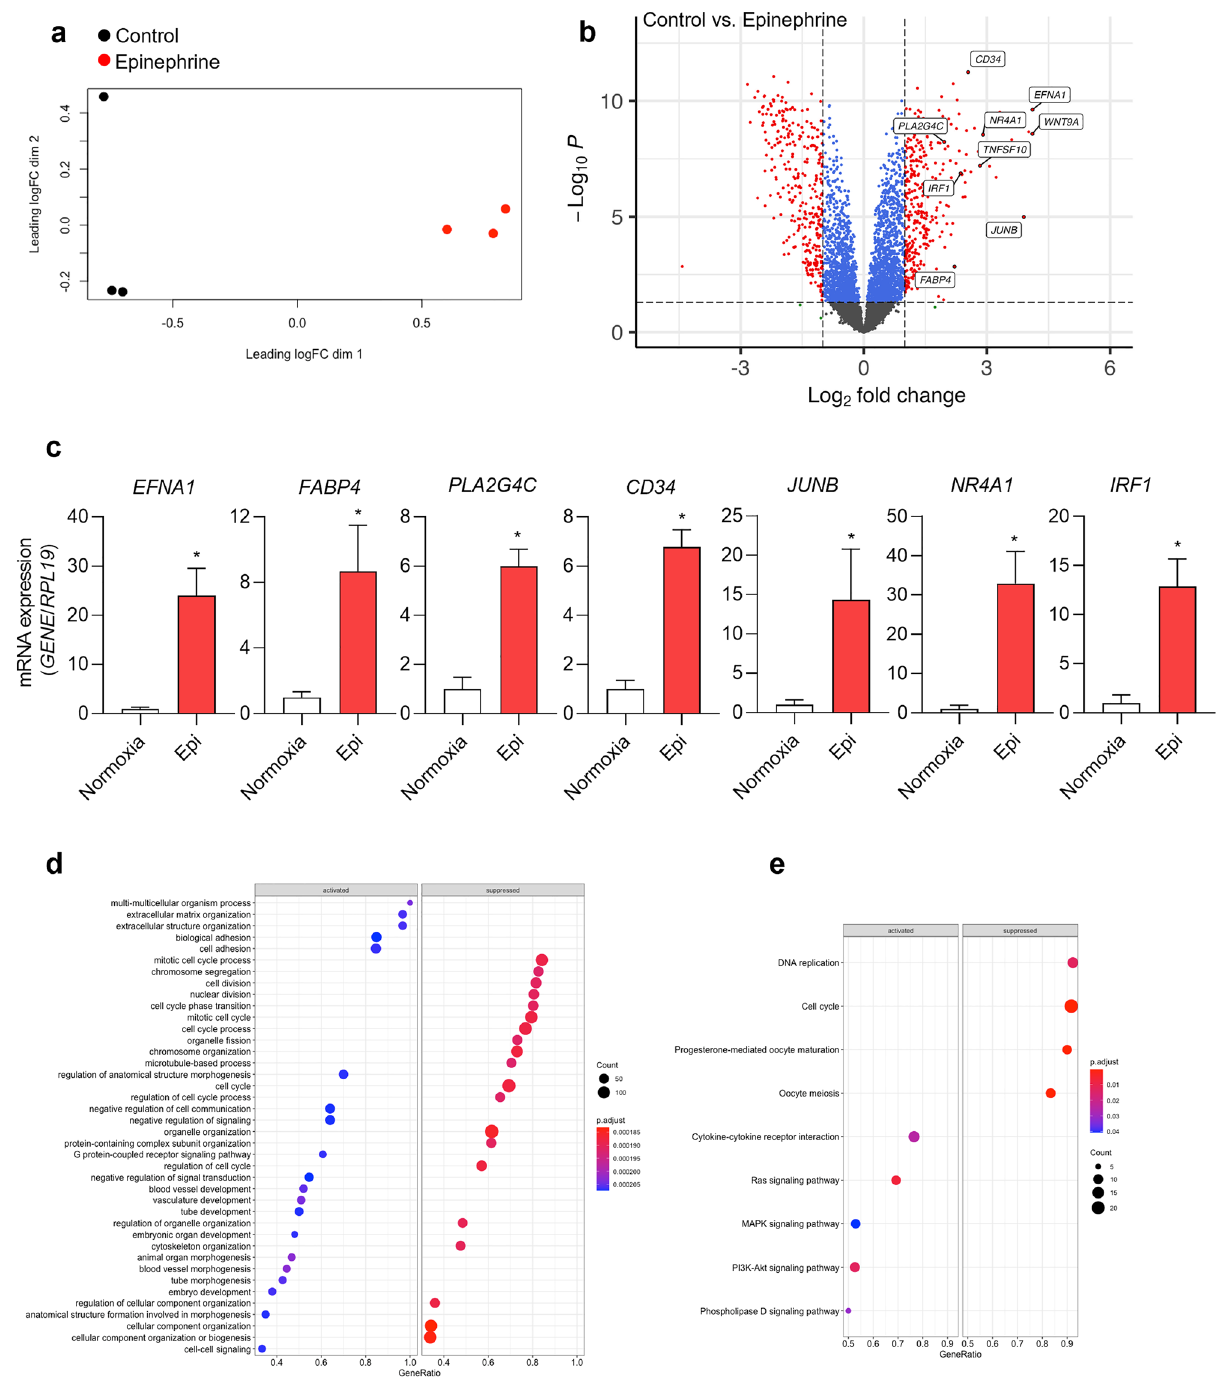
Figure 2. Transcriptional changes in human aortic endothelial cells after treatment with epinephrine. HAECs were treated with epinephrine (10 µM) or vehicle control for 7 h under normoxia (20% O 2 ) using the perfusion system. RNA-sequencing was performed from RNA isolated 3 biological replicates. ( a ) Multidimensional scaling plot of differentially expressed genes in HAECs treated with epinephrine or vehicle control. LogFC dim 1, and dim 2: base 2 logarithm of fold change dimension 1 and 2. ( b ) Volcano plot of -Log10 ( p values) vs. Log2 fold change for DEGs and top significantly upregulated genes upon epinephrine treatment. The -log10 ( p values) represents the level of significance of each gene while log2 fold change represents the difference between the levels of expression for each gene. ( c ) Using qPCR, we measured mRNA expression of EFNA1 , FABP4 , PLA2G4C , CD34 , Transcription factor jun-B ( JUNB ), Nuclear receptor subfamily 4 group A member 1 ( NR4A1 ) and Interferon regulatory factor 1 ( IRF1 ) in HAECs under control normoxia and IH (data are shown as mean ± SD, n = 6, biologic replicates). * p < 0.05. Parameters for DEG significance were set to absolute fold change ≥ 2 and FDR adjusted p value ≤ 0.05. Activated and suppressed gene ( d ) ontology biological processes (GO BP) and ( e ) activated and suppressed KEGG pathways were identified by gene set enrichment analysis of DEGs in HAECs treated with epinephrine compared to control